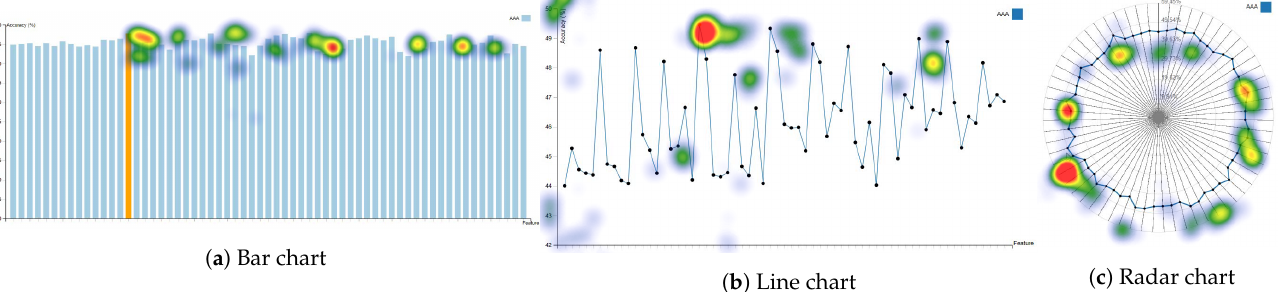
Figure 10. Heat maps of bar chart, line chart, and radar chart.